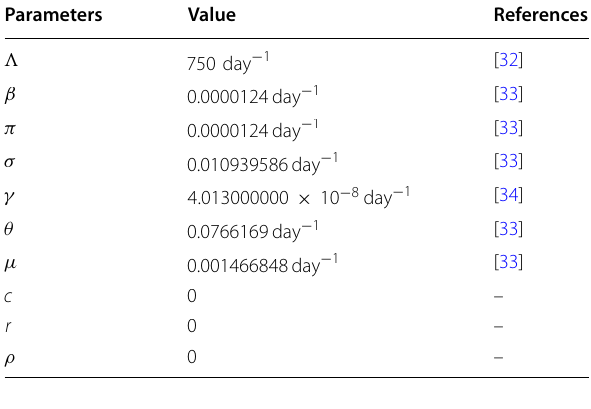
Table 2 Values of model’s parameter and